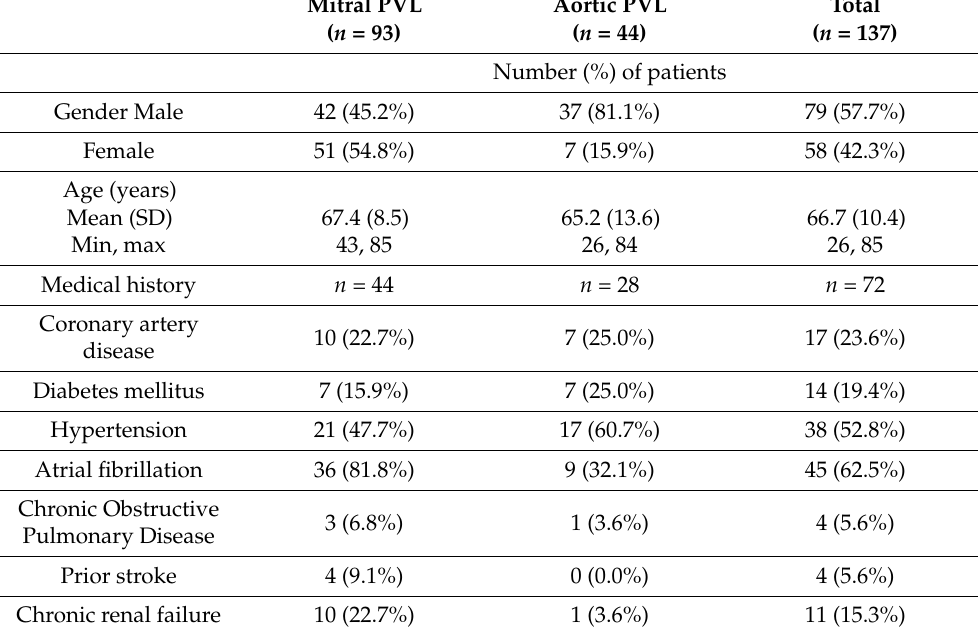
Table 1. Demographic characteristics, gender and medical history of study patients in the safety analysis set